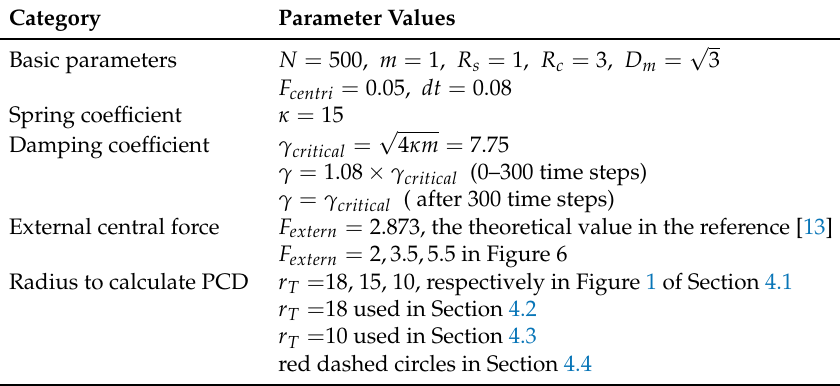
Table 1. Initial parameters used in simulation experiments of following subsections. Note: PCD, pair correlation diversion.